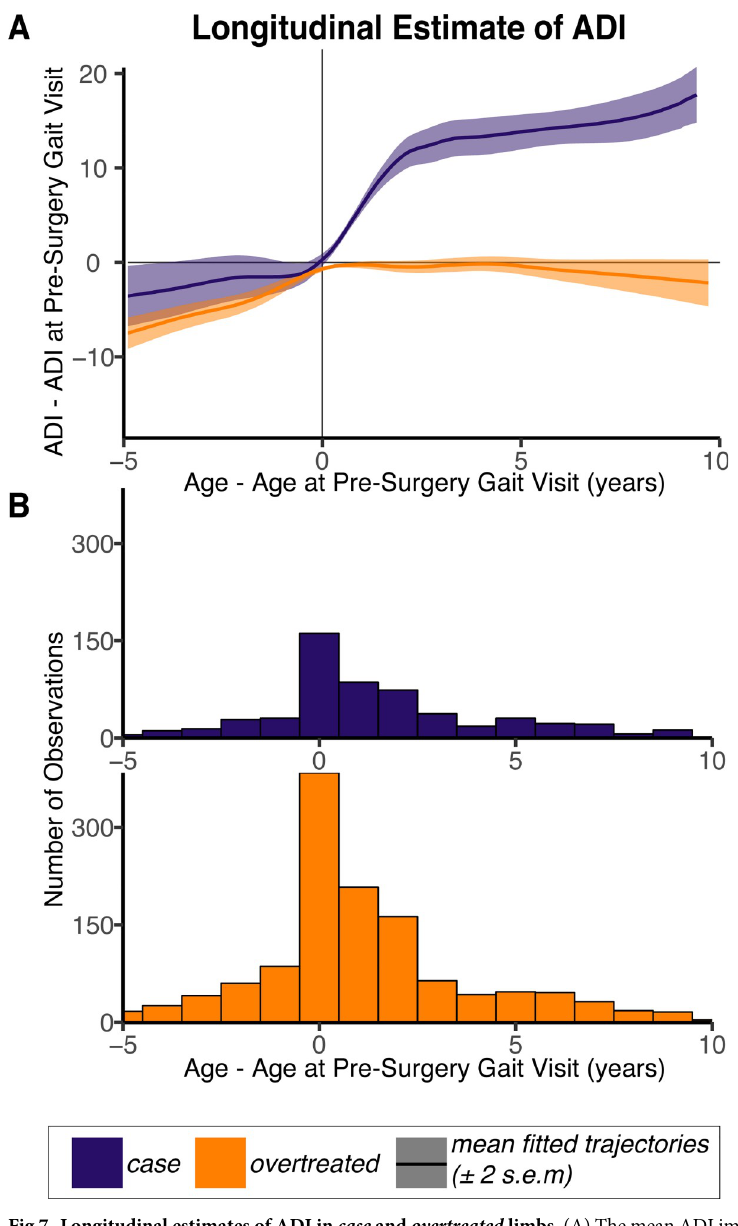
Fig 7. Longitudinal estimates of ADI in case and overtreated limbs. (A) The mean ADI improvement following surgery was estimated as a function of time elapsed since the pre-surgery gait visit. Case limbs had a greater improvement in ADI than the overtreated limbs at equivalent times. The shaded bands represent the 95% confidence interval for the case and overtreated group mean trajectories. (B) These longitudinal case and overtreated group estimates were based on available observations, which decrease in number as time from surgery